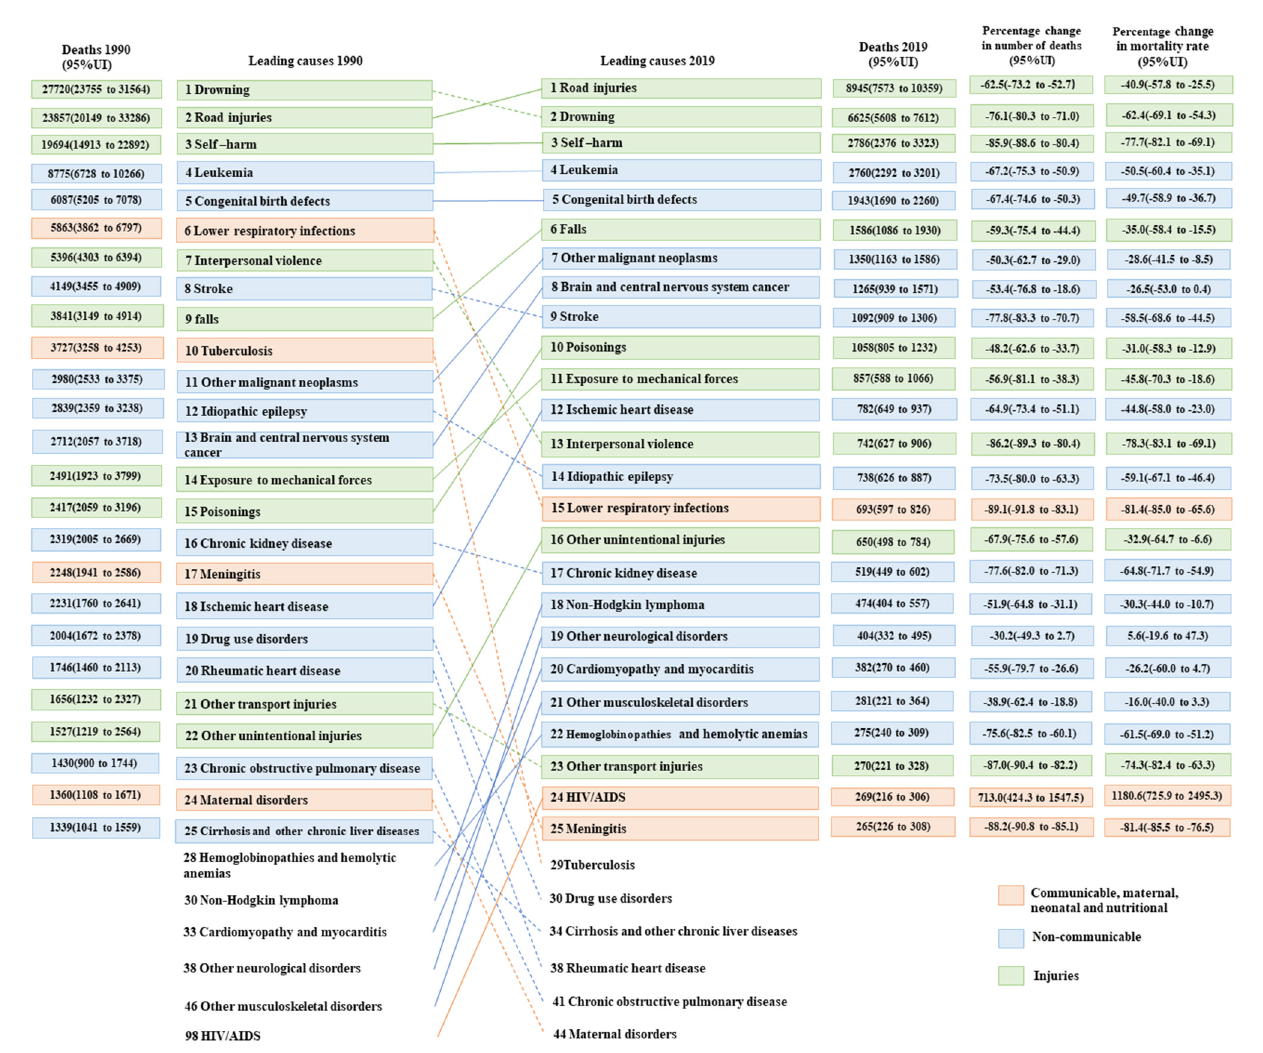
(26). Therefore, gender-specific policies are expected to further lower gender inequalities in mortality among Chinese